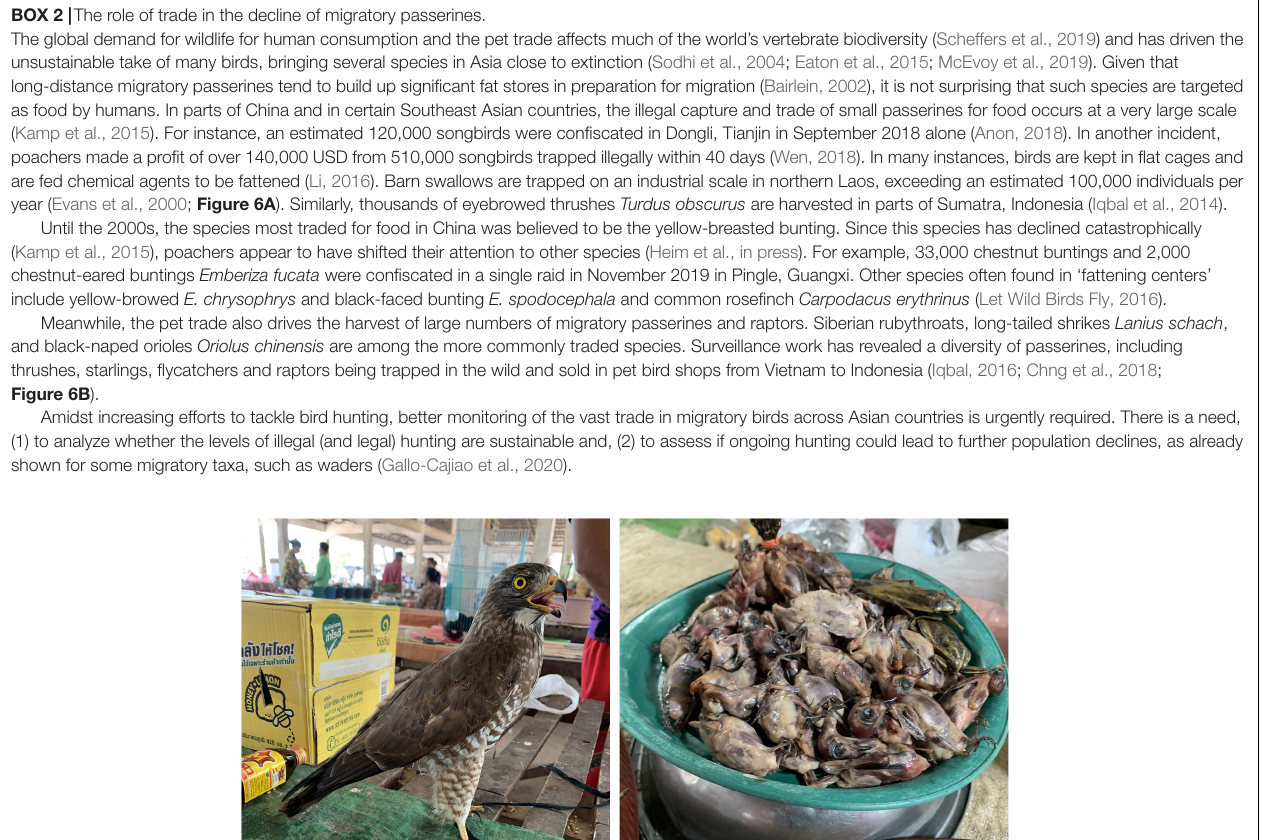
Frontiers in Ecology and Evolution |